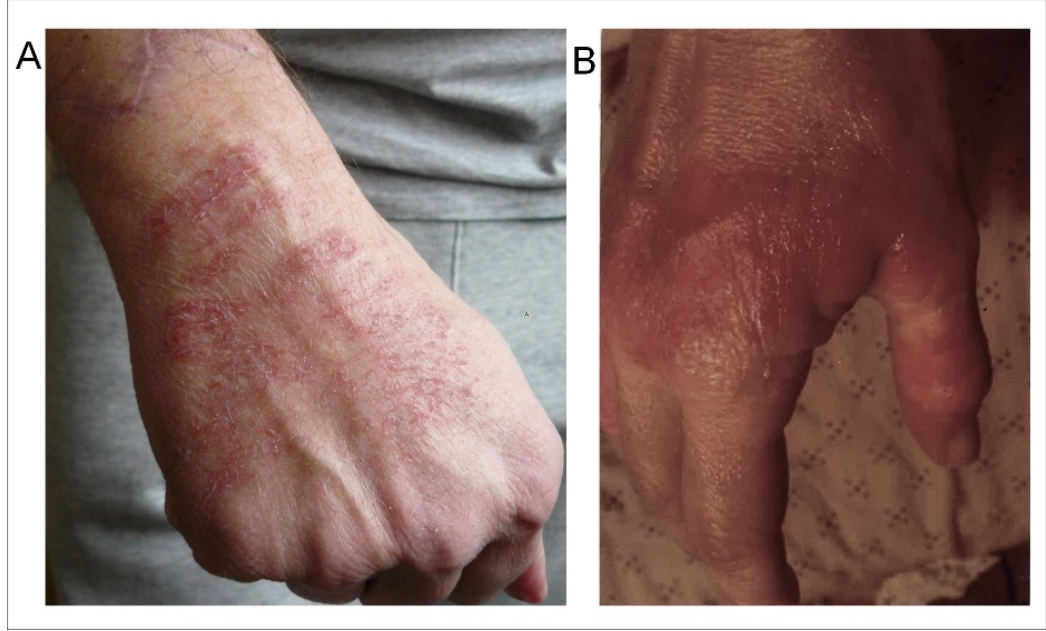
Figure 1. Examples of skin lesions observed on the hand of an EHS-bearing patient ( A ) and of an EHS/MCS-bearing patient ( B ). (Photographs are issued from the database).